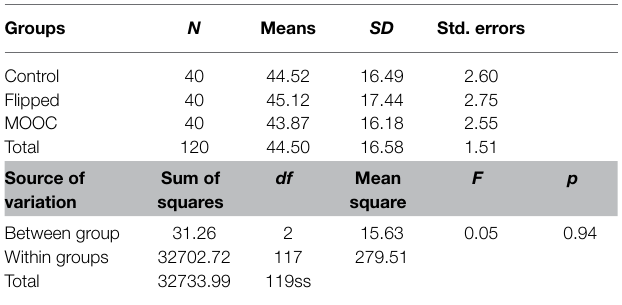
TABLE 2 | ANOVA results for anxiety pre-test. Groups